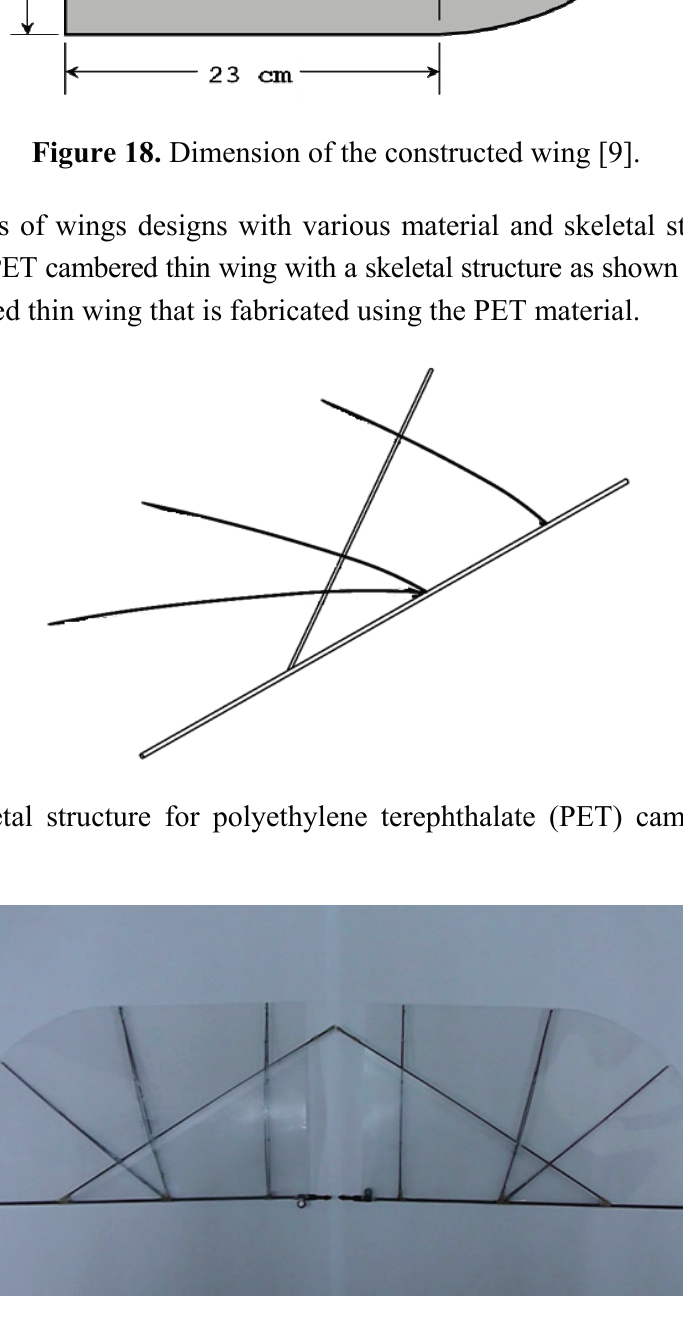
Figure 20. PET cambered thin